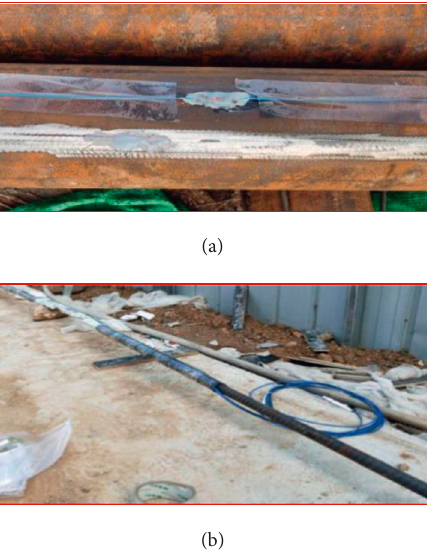
Figure 7: Steel pipe pile and anchor sensor installation. (a) Installation of FBG strain sensor. (b) Installation of FBG axial force sensor.